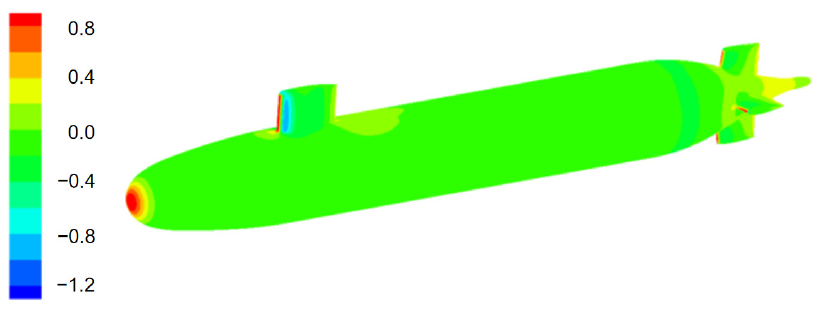
Figure 4. The pressure coefficients of submarine wall surfaces.